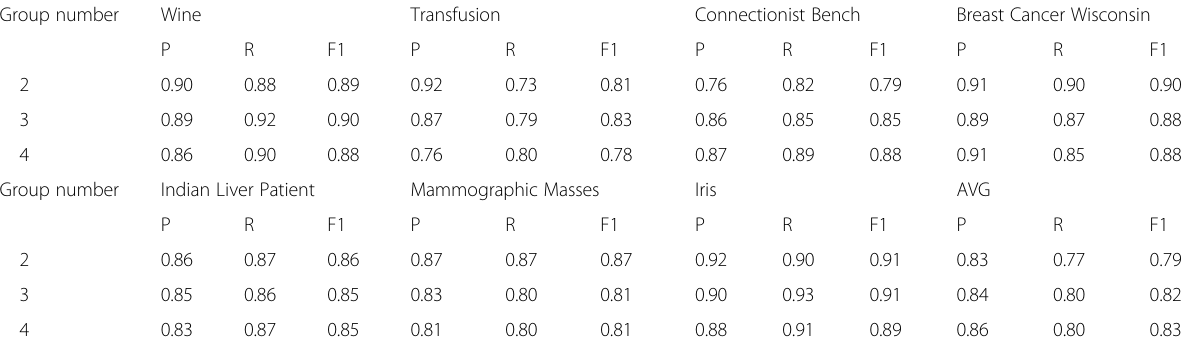
Table 9 The influence of the vertical grouping of UCI dataset in the GVCA method on classification performance Group